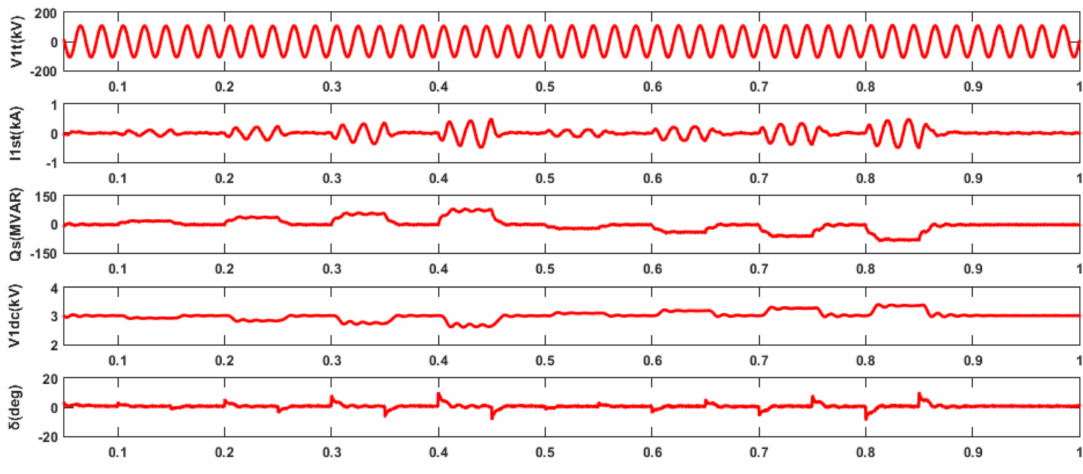
Figure 7. Disintegration loads performance results of seven level VSC based STATCOM with reference reactive power